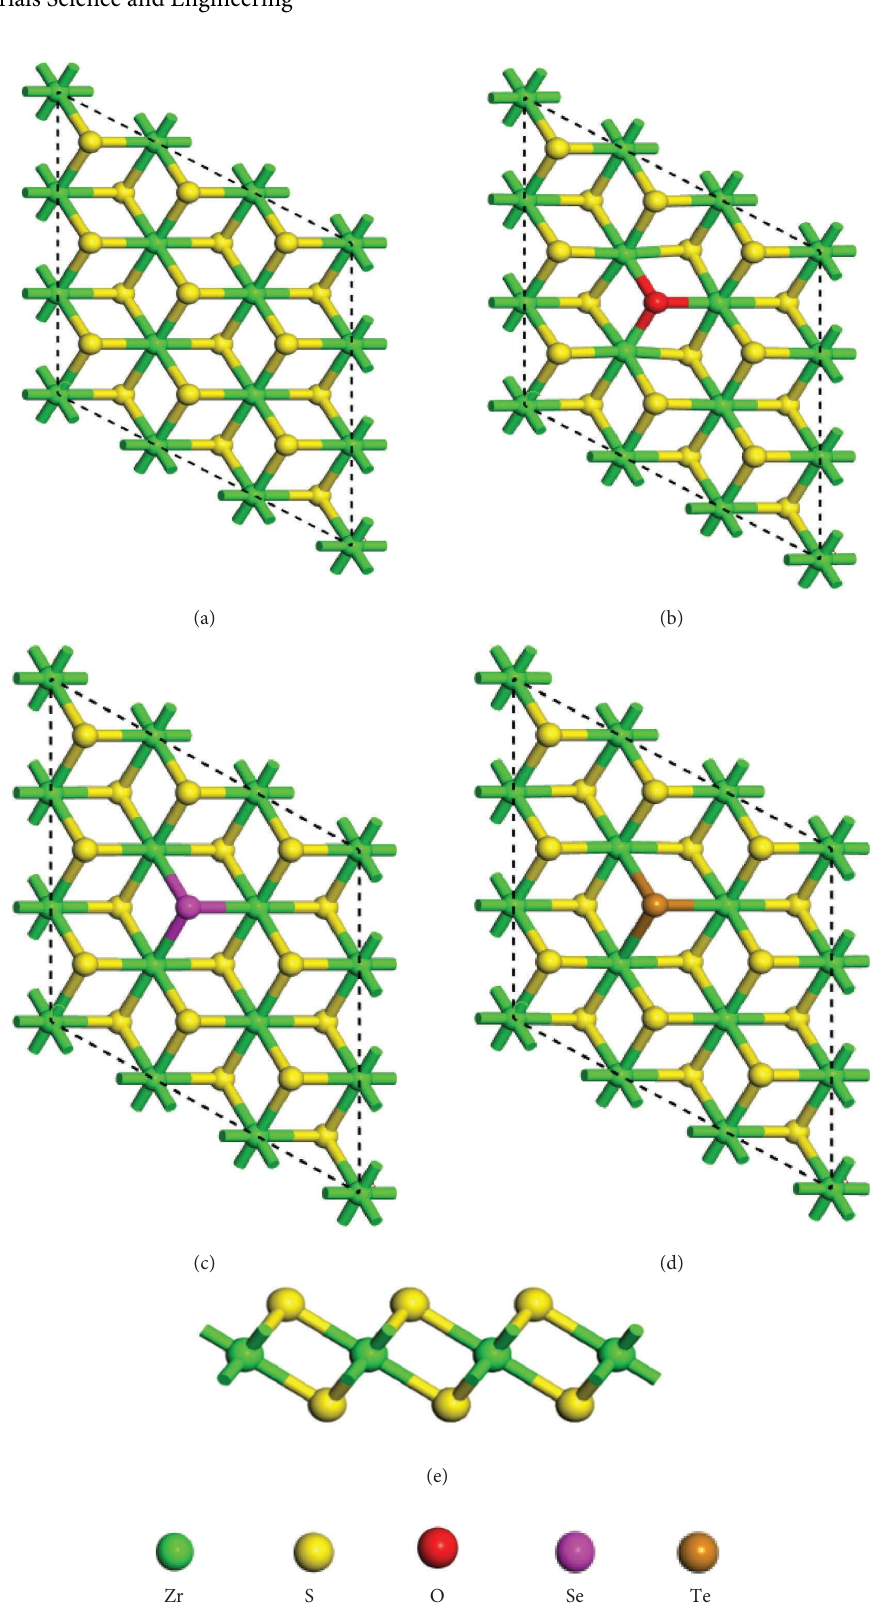
Figure 1: Optimised structures of the top and side view of the (a) pristine ZrS